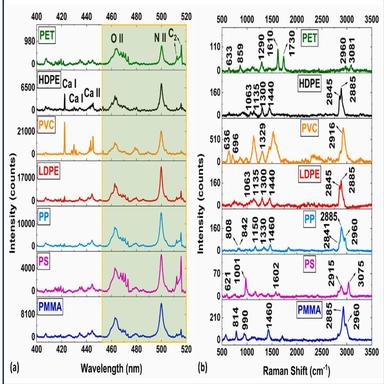
Comparison of spectral data from post-consumer plastics (a) LIBS and (b) Raman Spectra.